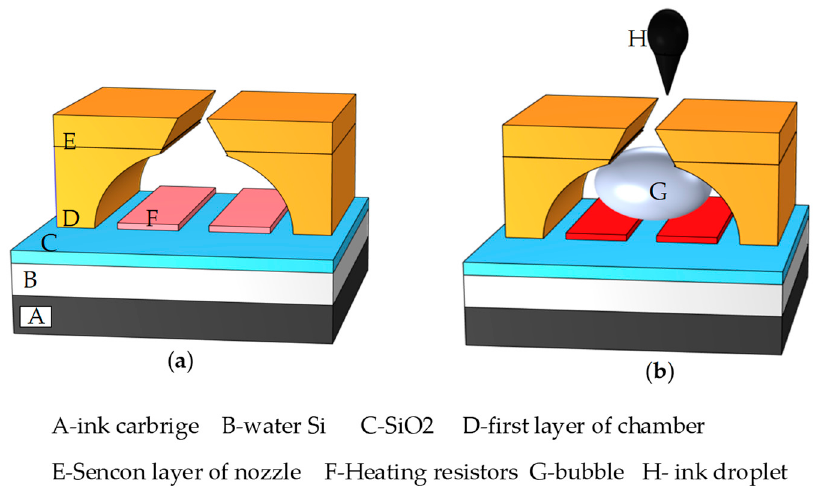
Figure 1. The working process of thermal inkjet head. ( a ) The structure of thermal inkjet head; ( b ) By heating the TaN film, the liquid in the chamber is vaporized to form a vapor bubble, which pushes the liquid out of the nozzle.